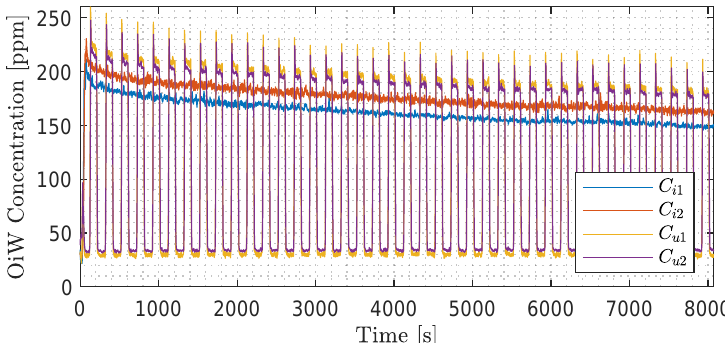
Figure 17. Slow settling of the mixture in the supply tank. During this experiment V o toggles from fully closed to fully open every 100